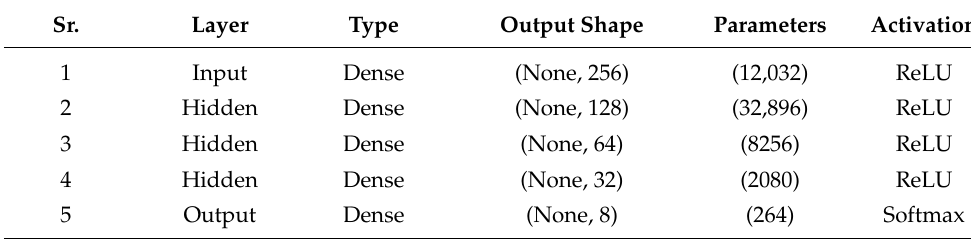
Table 3. Detailed model summary of multilayer perceptron network.